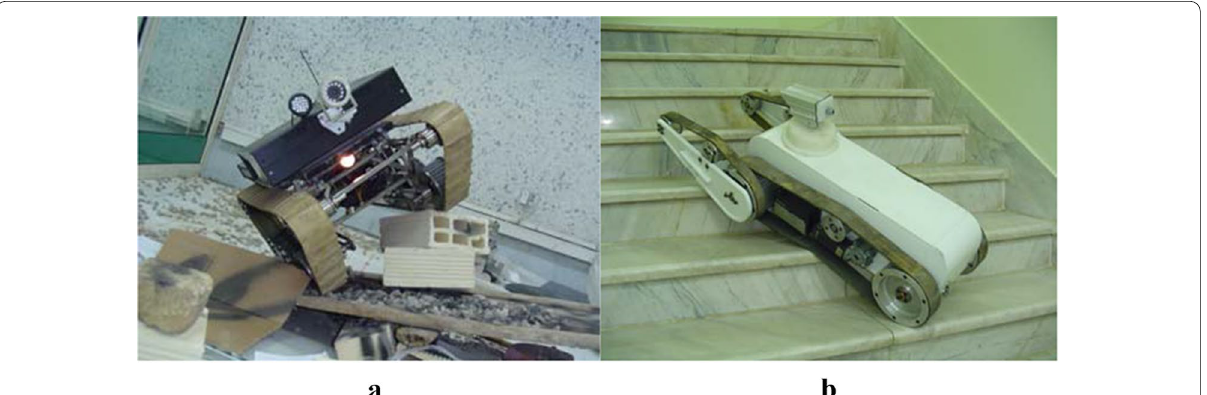
Fig. 1 Two of Karo’s ancestors: a NAJI-I in a field performance in 2003, and b NAJI-II under test and development procedure in 2004